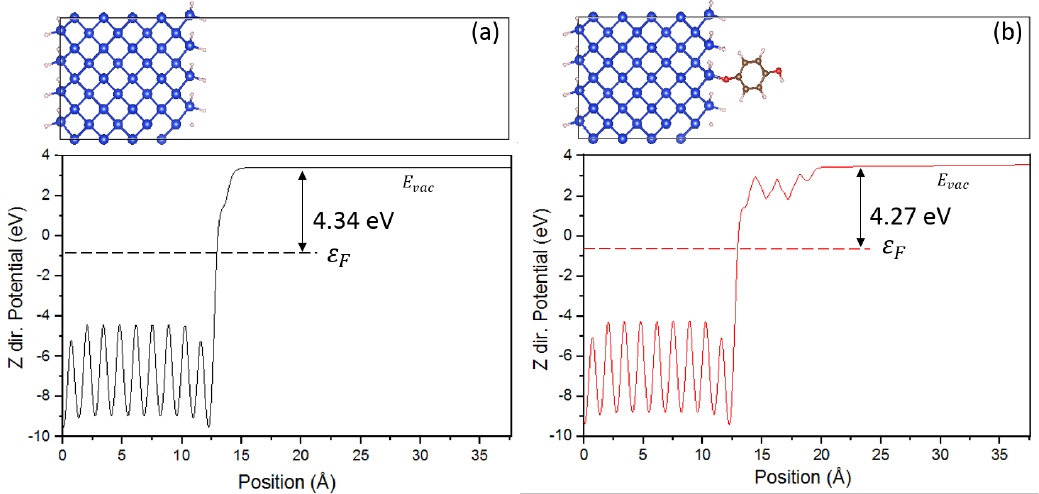
Figure 8. Cross-section of a unit cell and the corresponding laterally averaged electrostatic potential profile for the H-Si ( a ) and BQ-Si ( b ) slab. The potential difference between the Fermi level and the vacuum is denoted.